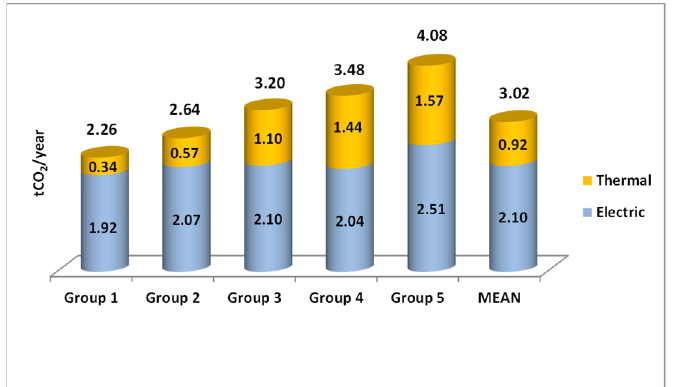
Figure 6. Thermal, electric, and total mean CO 2 emissions per household by group.